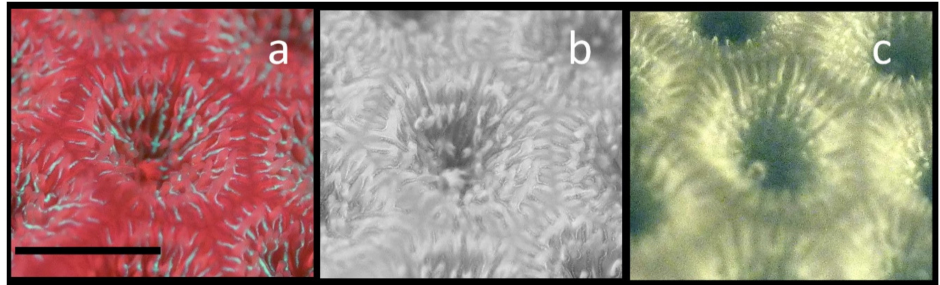
Figure 8. Demonstration of the ability to selectively image Chl even in the presence of red emitting GFPs. A single Siderastrea siderea polyp is shown. ( a ) Normal visible fluorescence image showing green GFP and red GFP fluorescence along with Chl red fluorescence in a single polyp. ( b ) Red portion only of the RGB image from ( a ). ( c ) The same polyp showing only the Chl NIR fluorescence image. For this image comparison, the contrast was enhanced in the NIR Chl fluorescence image. The scale bar in a is about 10